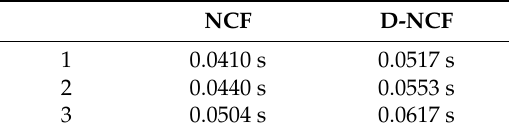
Table 5. The attitude estimation time of NCF and